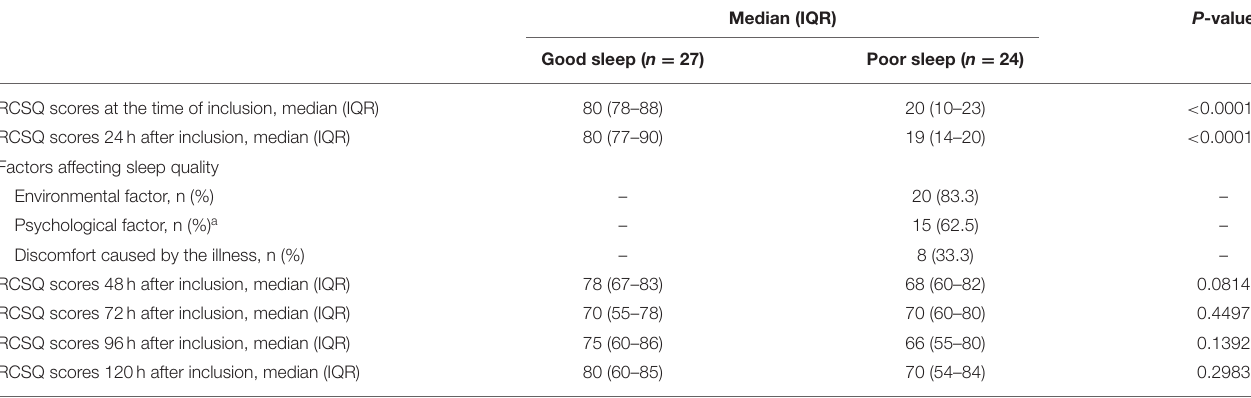
TABLE 1 | Sleep quality assessment in septic